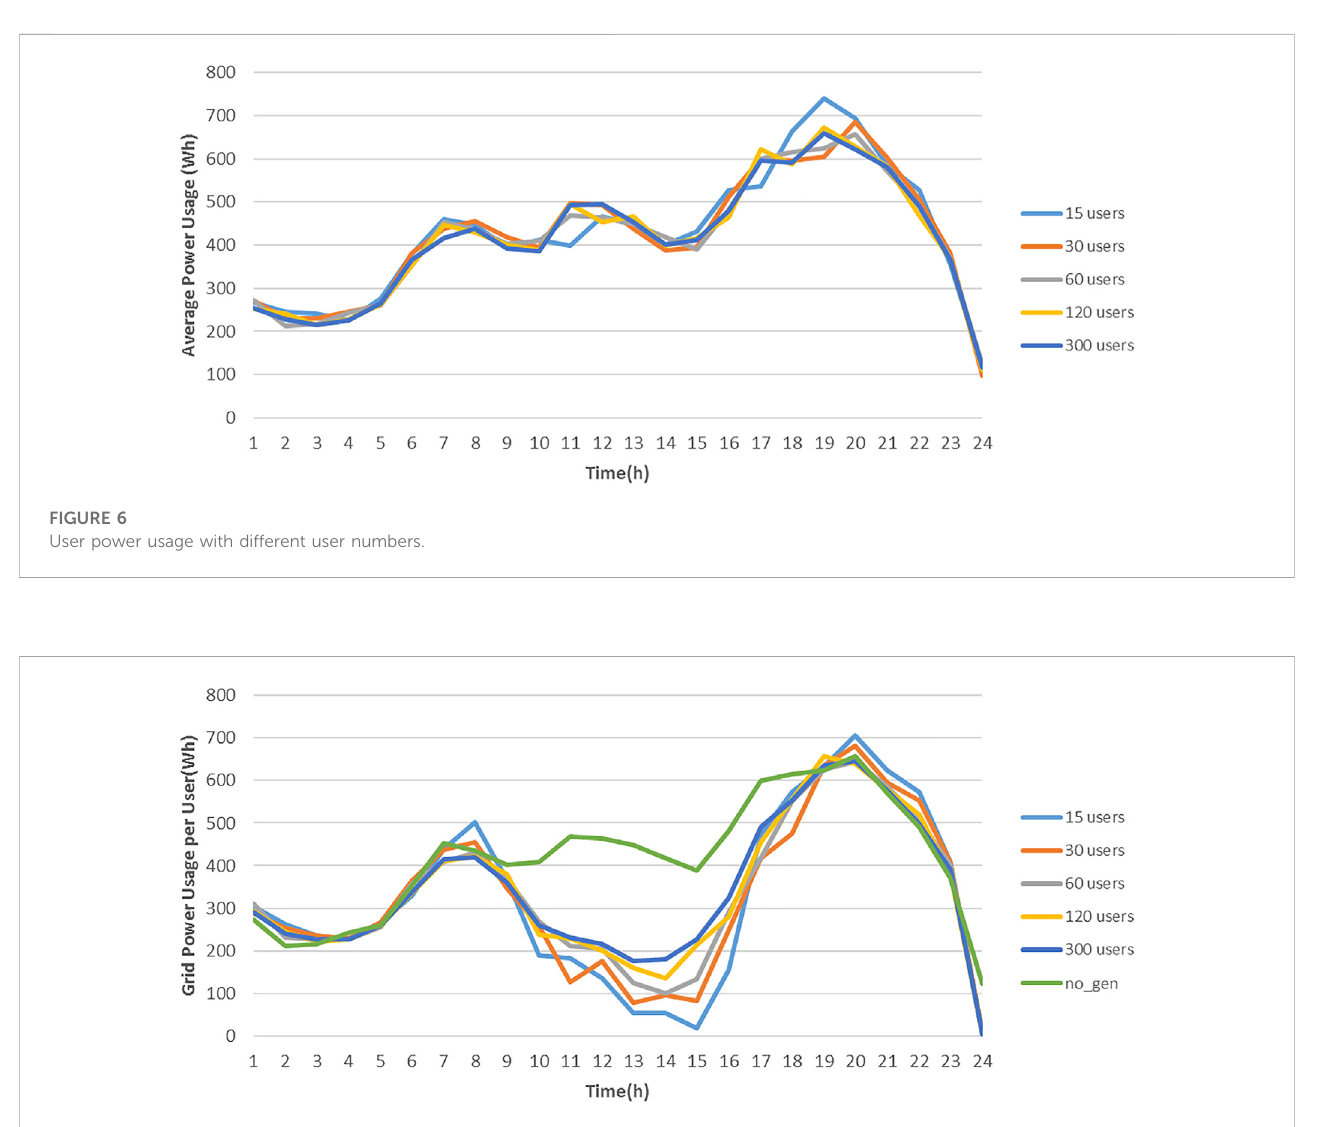
FIGURE 7 Grid power usage with different user